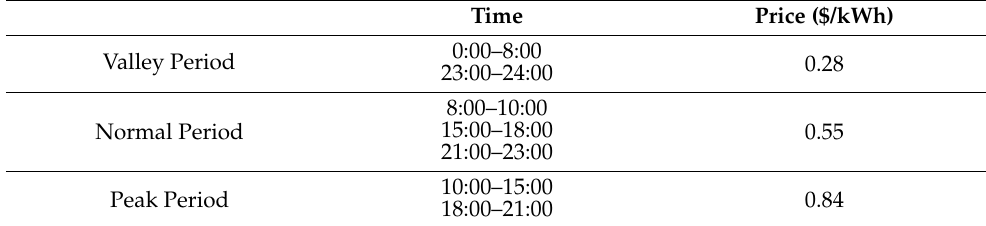
Table 2. Time-of-use price of electricity from the grid.